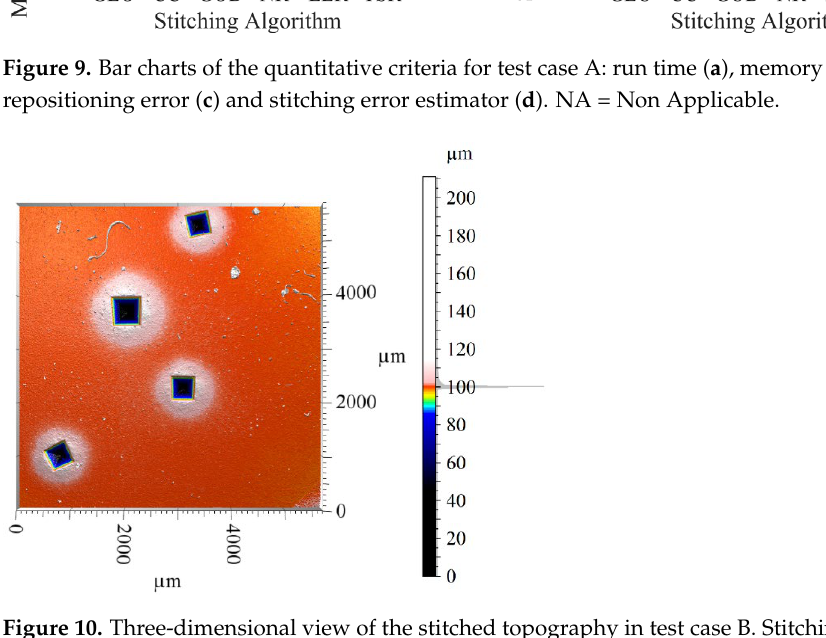
Figure 9. Bar charts of the quantitative criteria for test case A: run time ( a ), memory usage ( b ), mean repositioning error ( c ) and stitching error estimator ( d ). NA = Non Applicable.